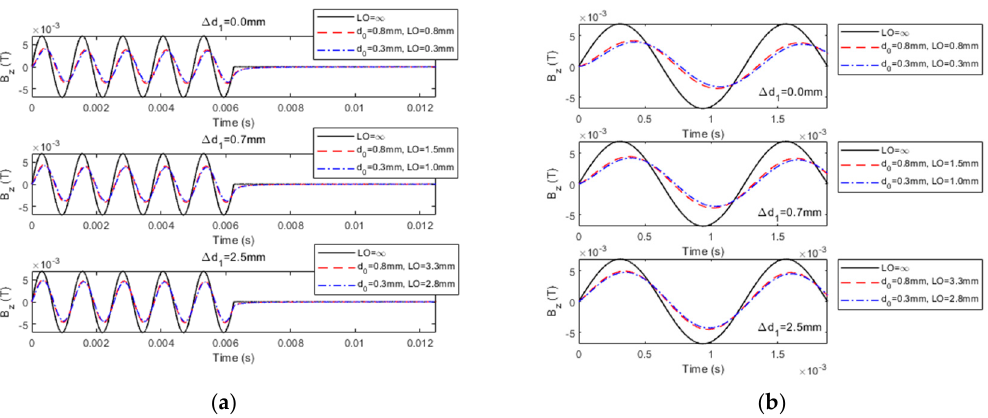
Figure 9. Testing signals indicating LOIs vs. ∆ d 1 against differential LOs: ( a ) signals in the one-cycle excitation; ( b ) zoom-in curves in the temporal window of 0 ms ≤ t ≤ 2 ms.